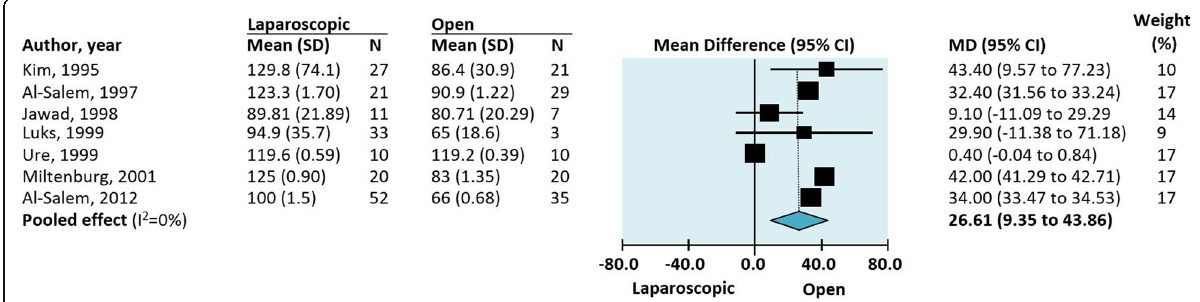
Fig. 3 Mean difference for operative time (minutes) in studies comparing laparoscopic cholecystectomy versus open cholecystectomy. Studies ordered chronologically. Positive values favour open cholecystectomy group. SD = standard deviation; N = sample size; CI = confidence interval; MD = mean